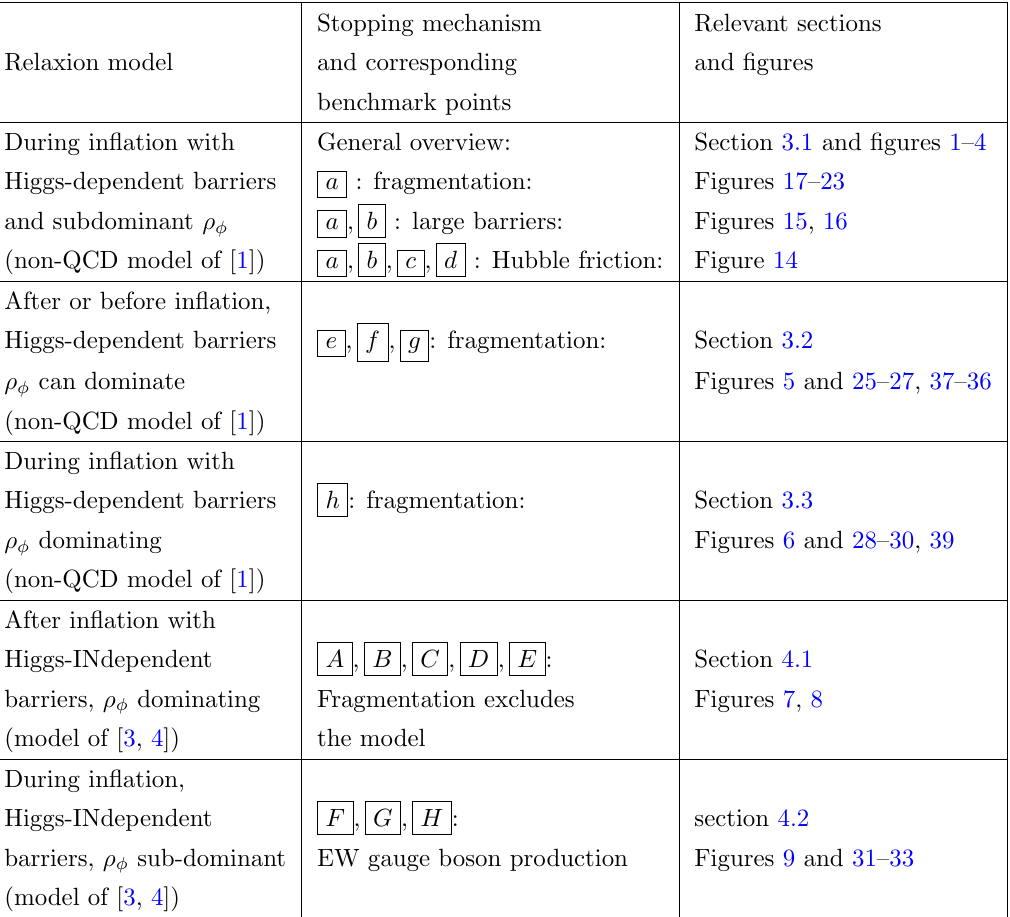
Table 2 . Summary of relaxion models examined in this paper with their benchmark points analysed in the respective